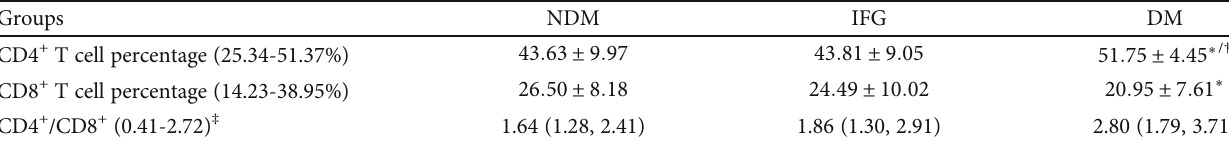
Table 3: T cell subsets among NDM, IFG, and DM.